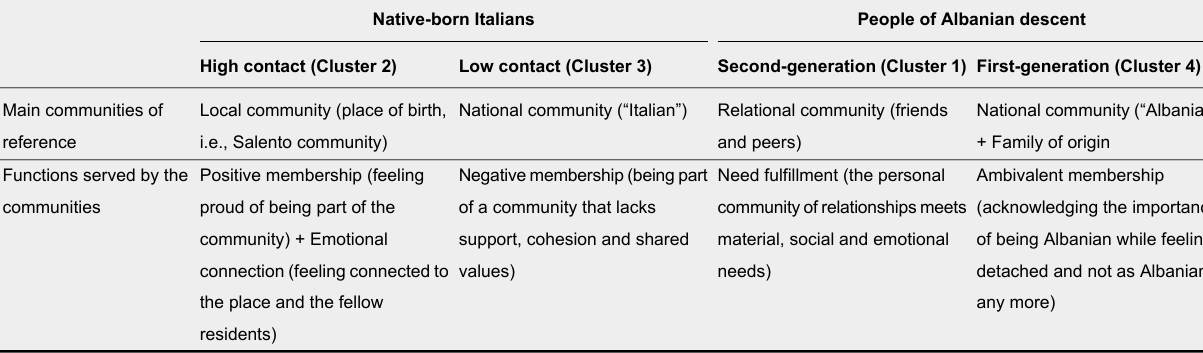
Synoptic view of the Communities of References and the Functions Served by the Communities in each Cluster